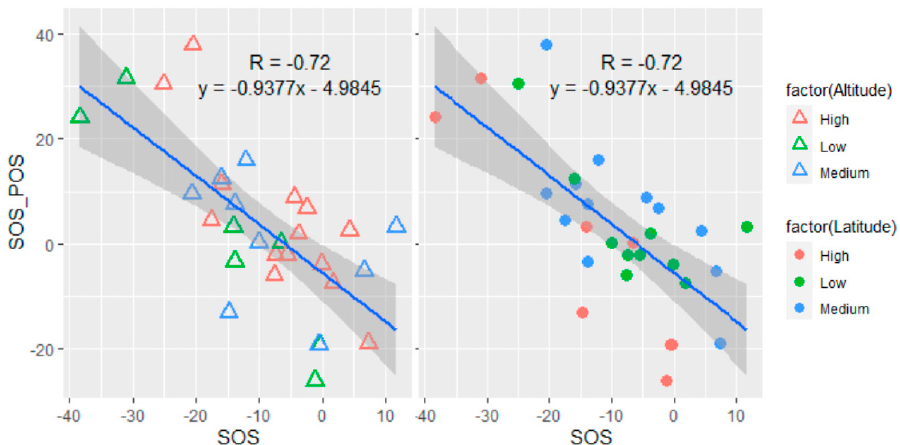
Figure 8. Relationships between changes in SOS-POS duration and changes in SOS during the period 2001–2021. Figures represent the same equation, highlighting sites graphically according to altitude (left) or latitude (right). Sites are divided into 3 different classes of altitude (low, 0–650 m; medium, 650–1300 m; high +1300 m) and latitude (low, 40–45°; medium, 45–50°; high +50°).